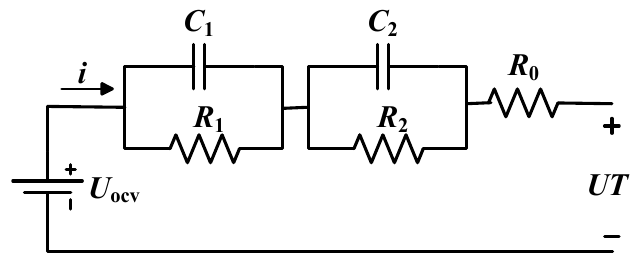
Figure 2. DP Equivalent circuit model.